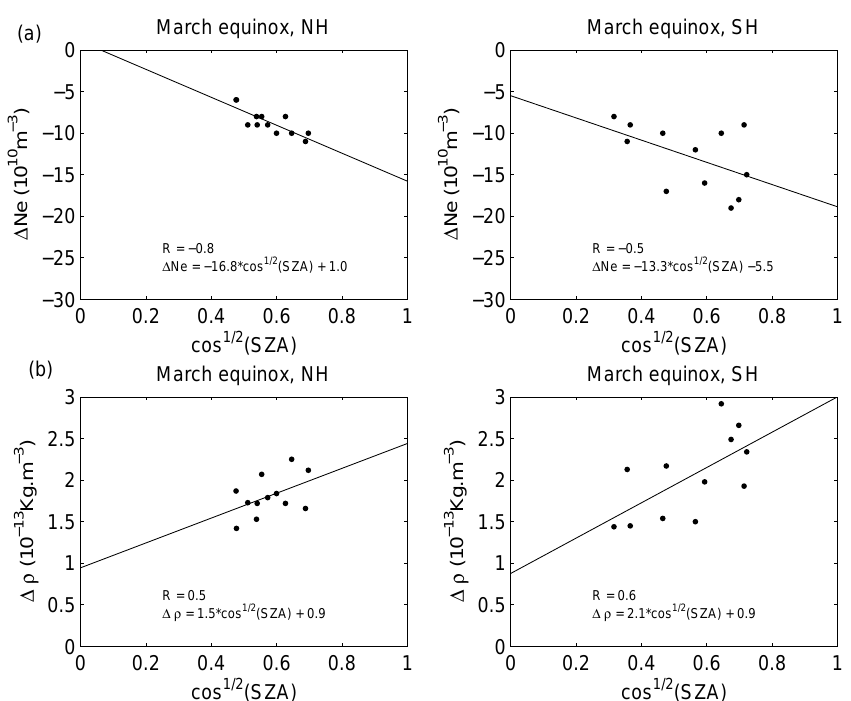
Figure 7. The top row shows a correlation analysis of the largest disturbance electron density at subauroral latitude with cos 1 / 2 (SZA) in both hemispheres. The bottom row shows a correlation analysis between the peak disturbance air mass density with cos 1 / 2 (SZA) in both hemispheres. The correlation coefficient ( R ) and linear relationship between the parameters are shown in each plot.